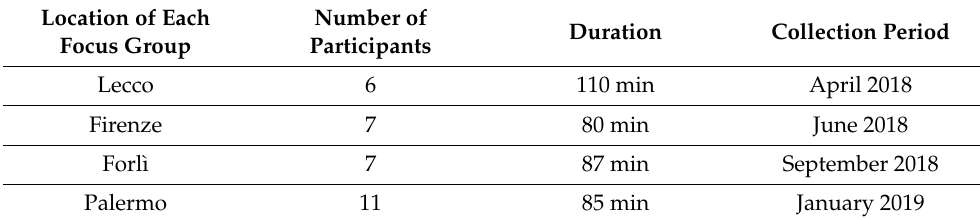
Table 1. Number of caregivers who participated to each focus groups.